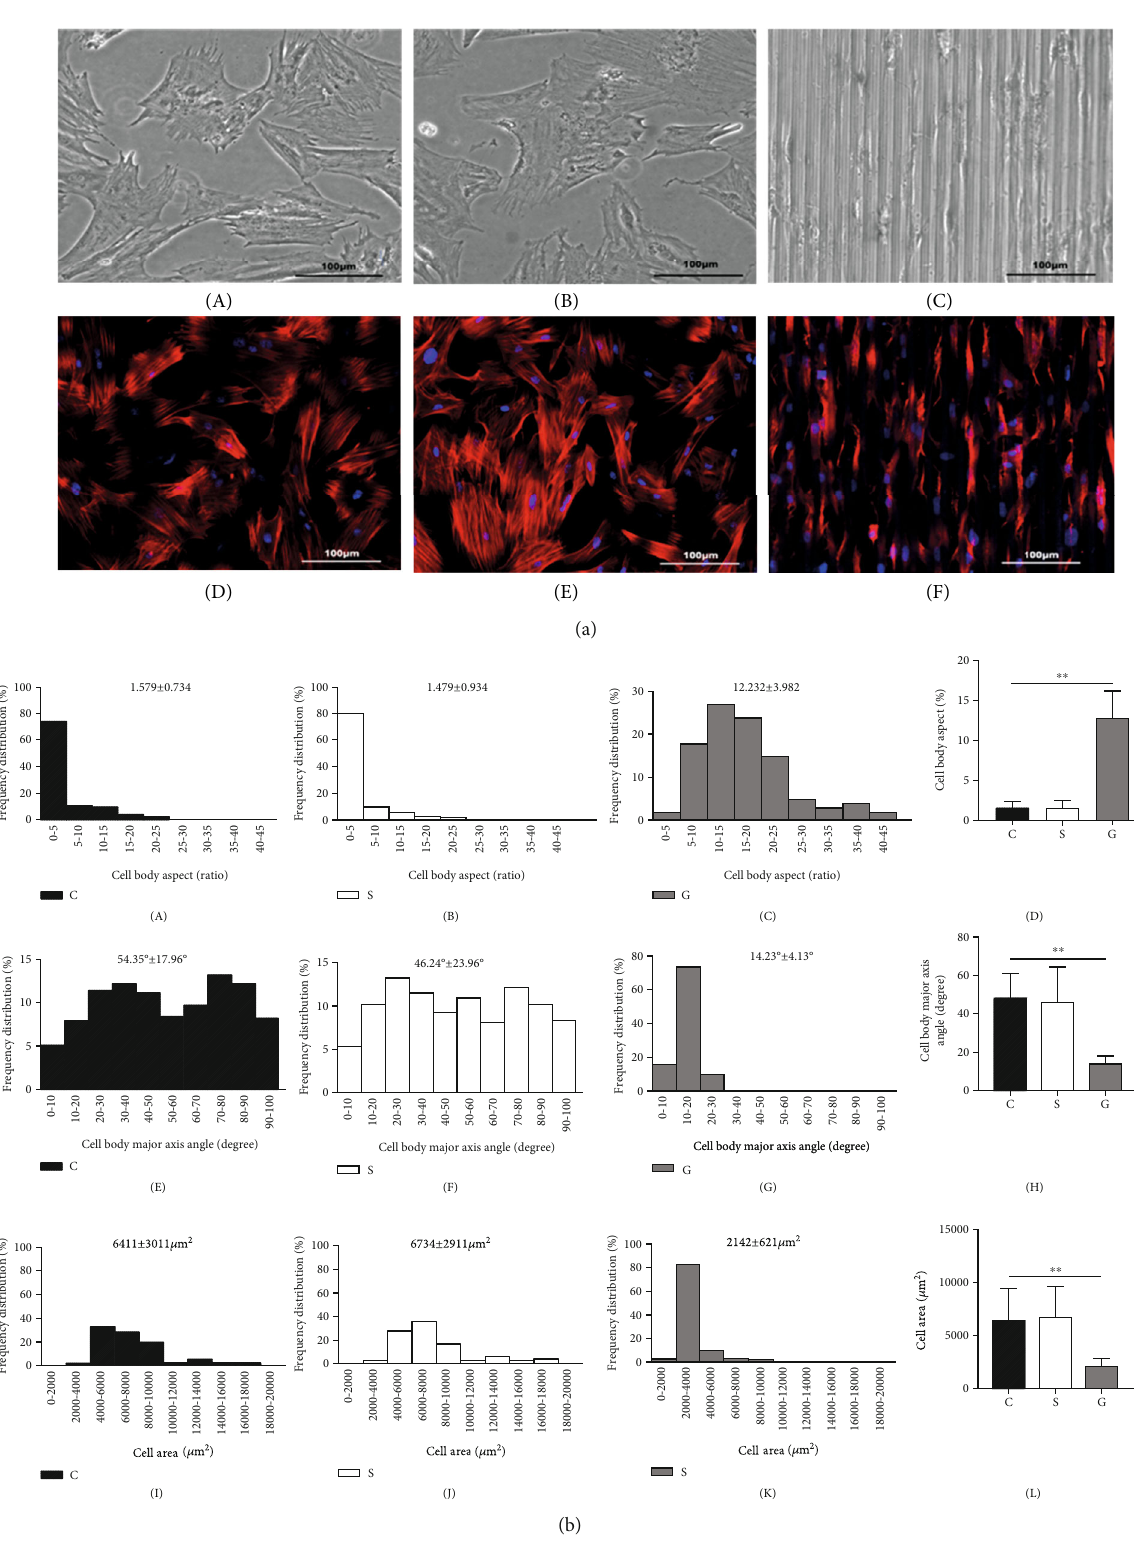
Figure 3: The cell morphology of TSPCs on di ff erent matrix surfaces. (a) Cell morphology observation: (A – C) cell morphology under a light microscope; (D – F) the morphology of TSPCs under a confocal laser scanning microscope. The nuclei were stained blue; the cytoskeletons were stained red; (A, D) TSPCs in the cell culture plate; (B, E) TSPCs on the smooth SF fi lm; (C, F) TSPCs on the SF fi lm with a microstructure. (b) Analysis of cell morphology: (A – D) cell body aspects; (E – H) cell body major axis angle (I – L) cell area; group C: TSPCs on the cell culture plate; group S: TSPCs on the smooth SF fi lm; group G: TSPCs on the SF fi lm with a microstructure; ∗∗ P < 0 : 01